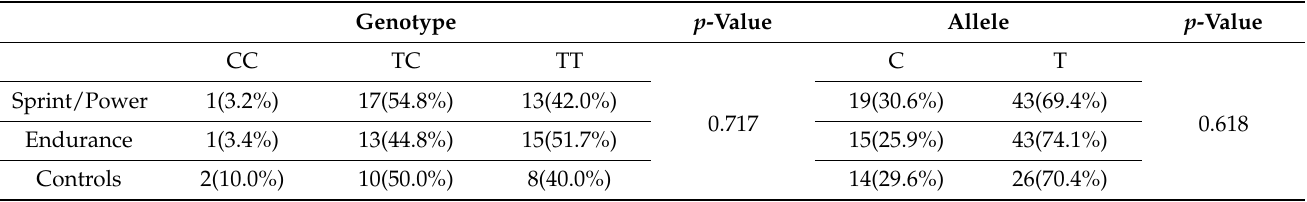
Table 1. Genotype and allele frequencies of VDR rs2228570 polymorphism in elite athletes and controls.